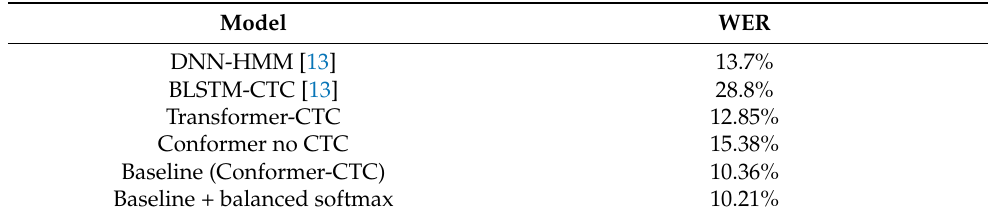
Table 4. Comparison experiments between the Conformer model using balanced softmax and other